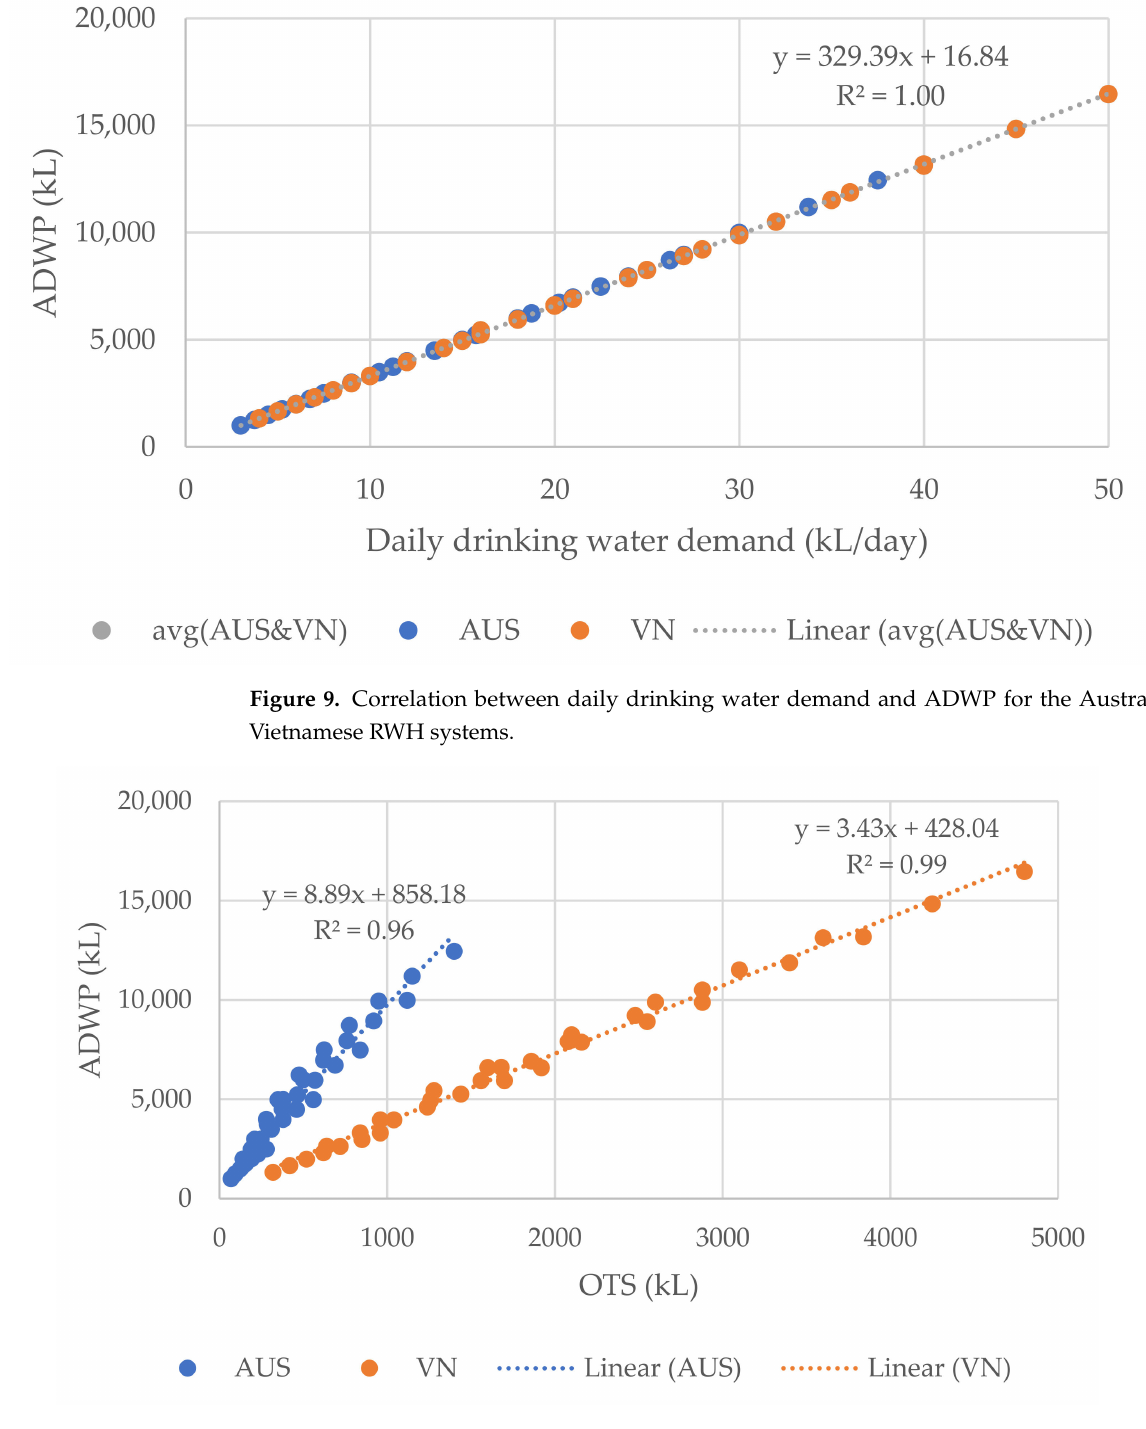
Figure 10. Correlation between ADWP and OTS for the Australian and Vietnamese RWH